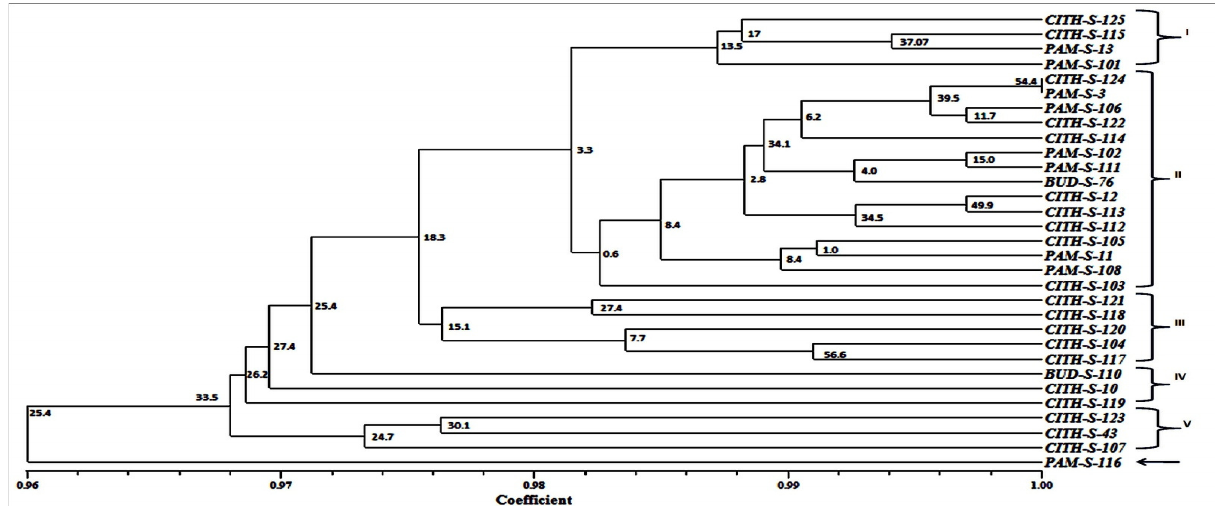
Fig. 1. UPGMA dendrogram showing clustering pattern of saffron selections. The bootstrap values are given on the